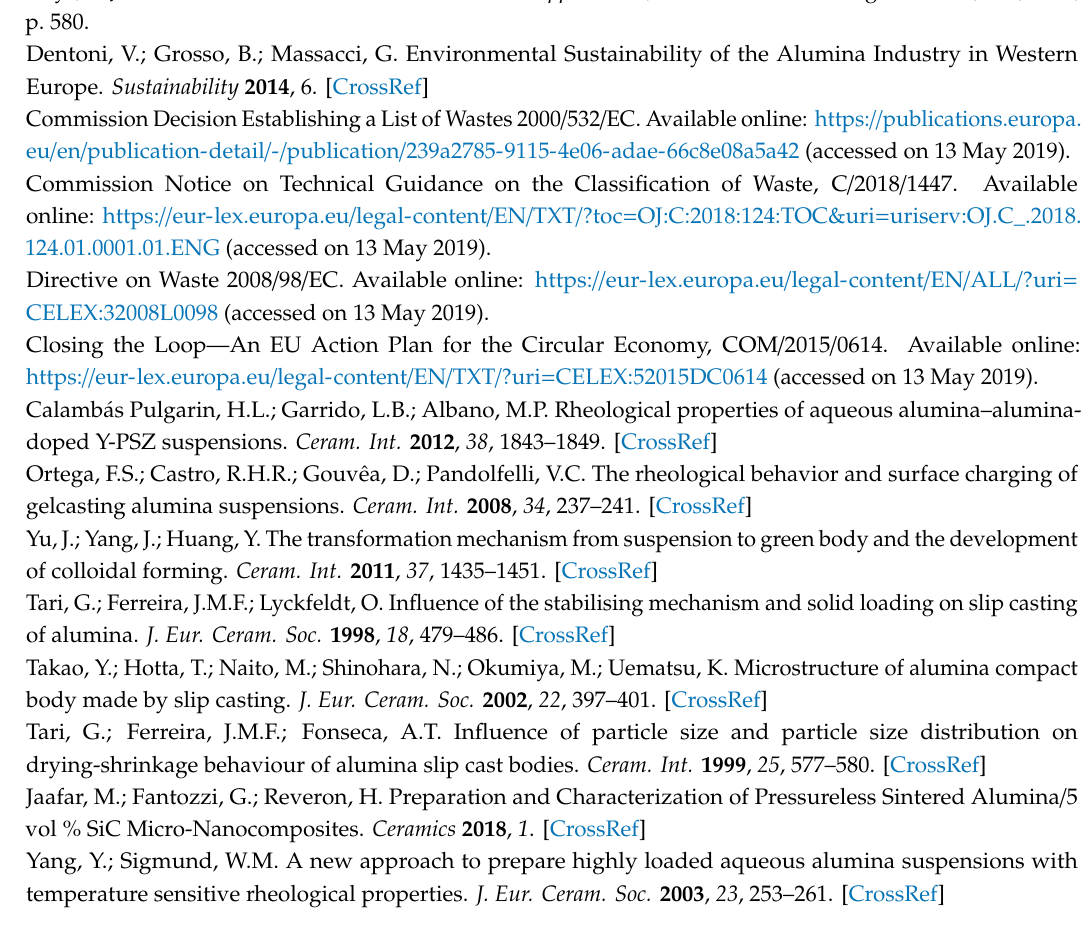
Figure A5. The e ff ect of sintering temperature on the densification of the sintered Figure A5. The effect of sintering temperature on the densification of the sintered sample.